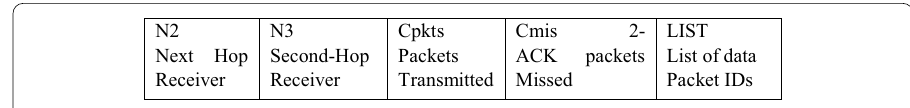
Fig. 4 Data structure maintain by observing